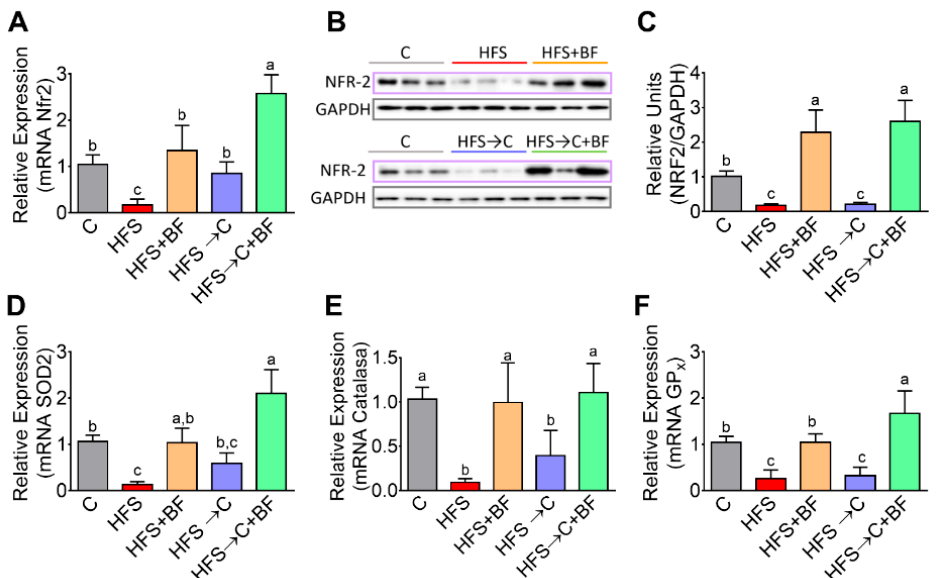
Figure 7. Hepatic antioxidant enzymes increased by consumption of bioactive foods. ( A ) Relative expression of mRNA abundance of Nfr2, ( B ) protein abundance of Nfr2 assessed by western blot analysis, and ( C ) densitometric analysis, relative expression of mRNA abundance of ( D ) Superoxide dismutase 2, ( E ) Catalase, and ( F ) Glutathione peroxidase in liver of rats fed control (C) or high fat diet + 5% sucrose (HFS) with or without bioactive foods. Data are expressed as the mean ± SD. Mean values with different letters show statistical differences between each other. Data were analyzed by one-way ANOVA followed by Tukey post-hoc test. Results were considered statistically significant at p < 0.05.